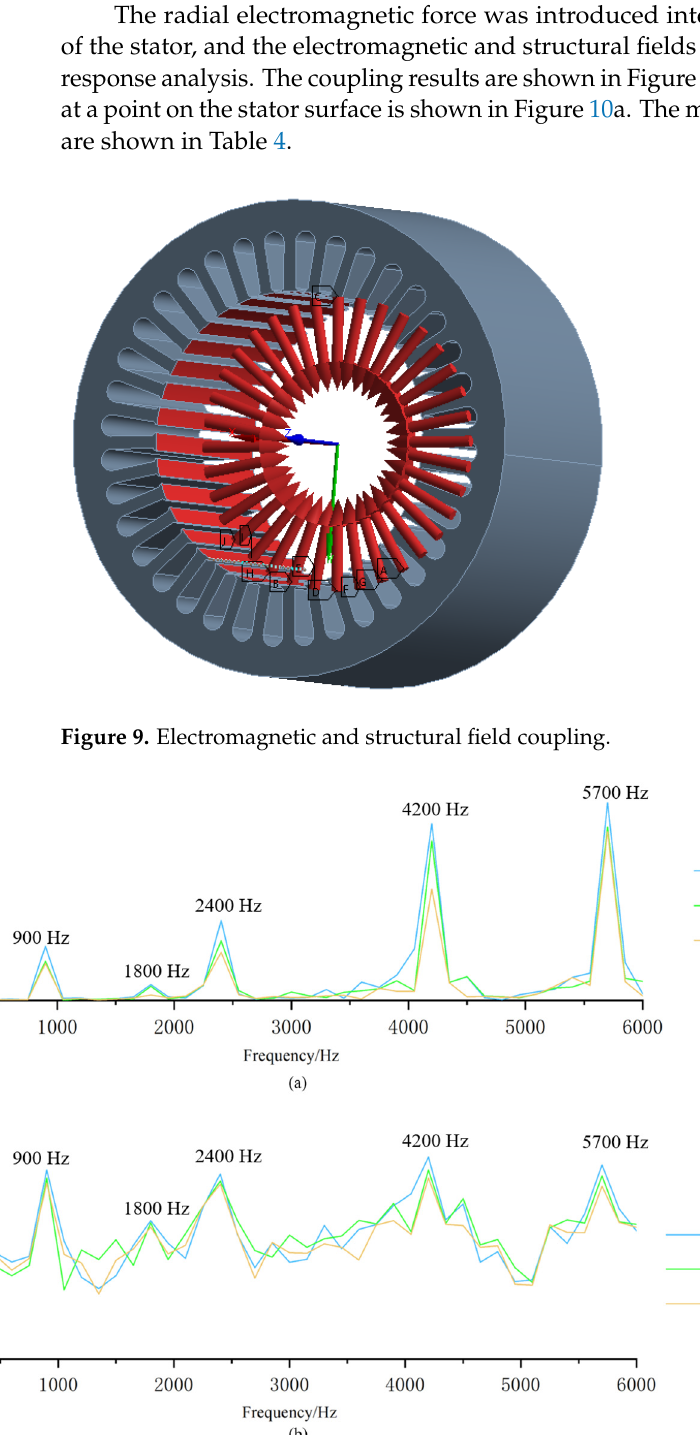
Figure 8. Zeroth-order electromagnetic force after removal of zero frequency multiplication.